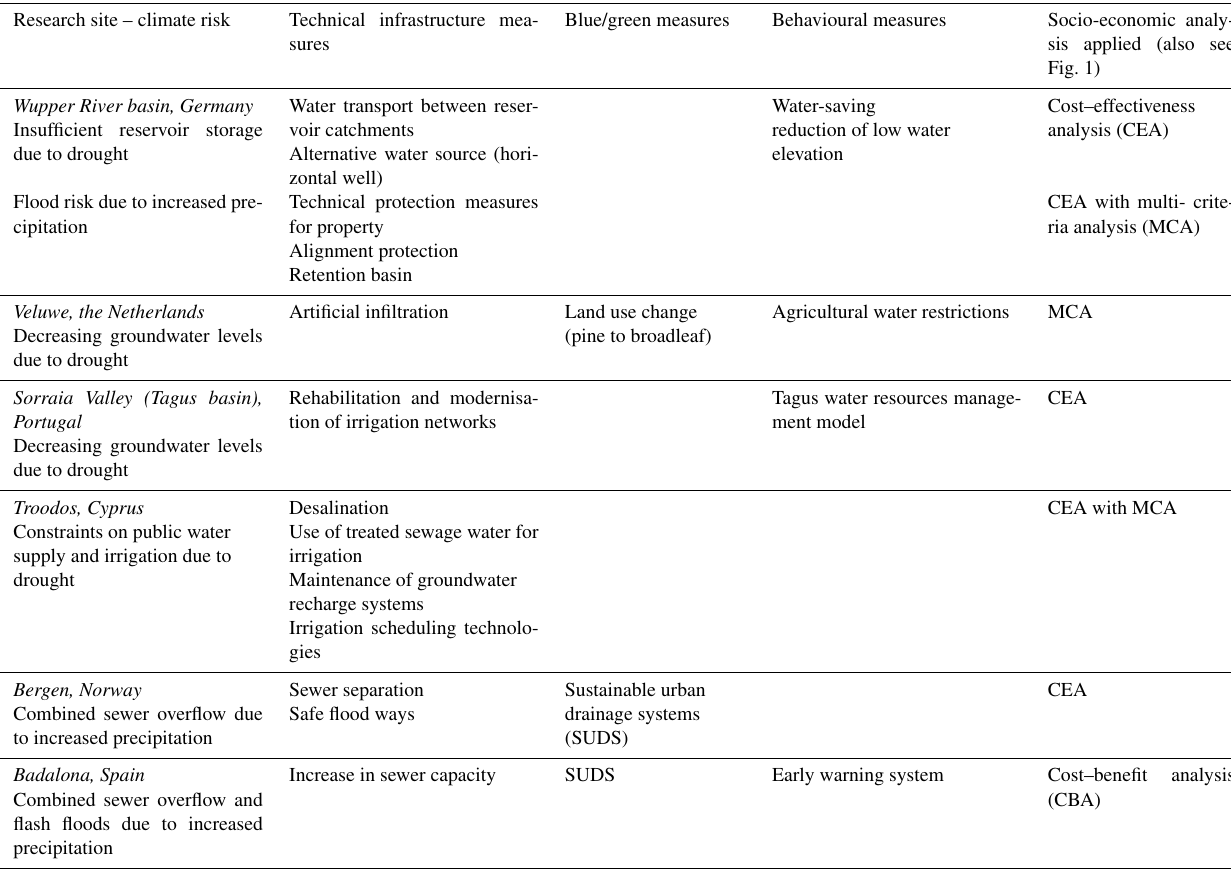
Table 1. Overview of adaptation measures selected by the research